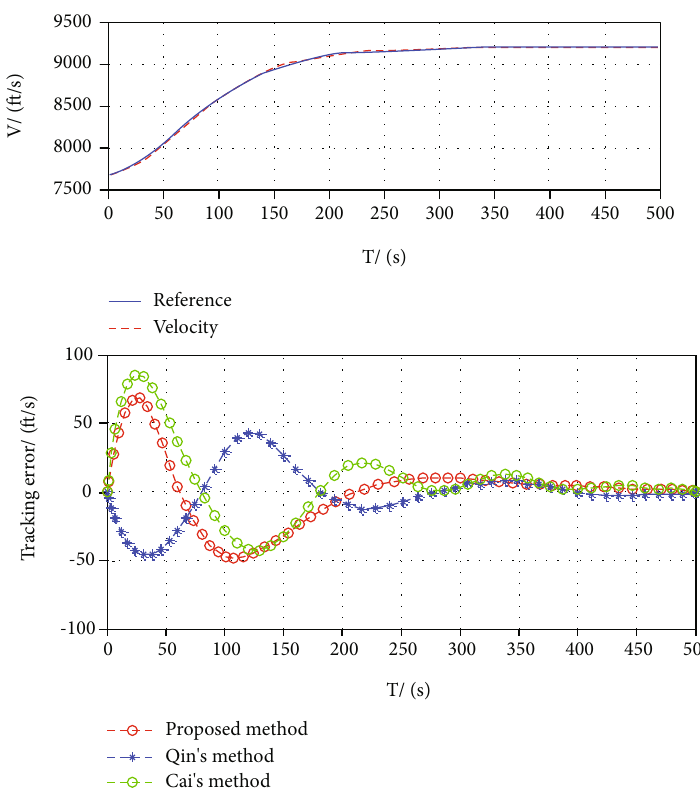
Figure 5: Velocity tracking performance and tracking